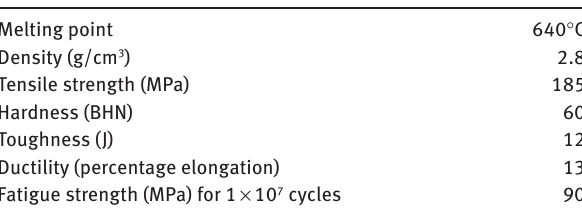
Table 3: Measured properties of AA2014 alloy.